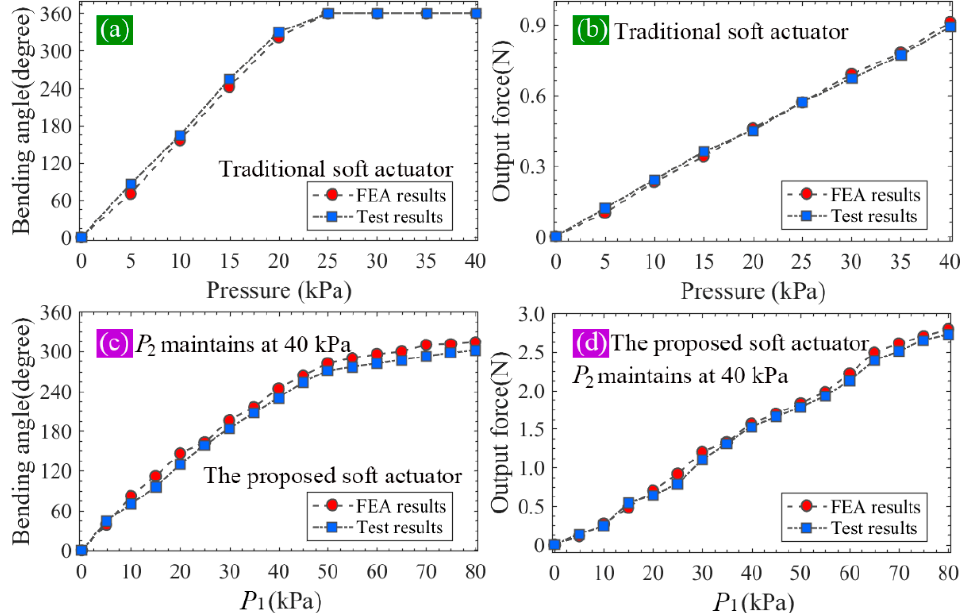
Figure 13. ( a , b ) The bending angle and output force of the traditional soft actuator under different pressures and ( c , d ) the bending angle and output force of the proposed soft actuator under different pressures.